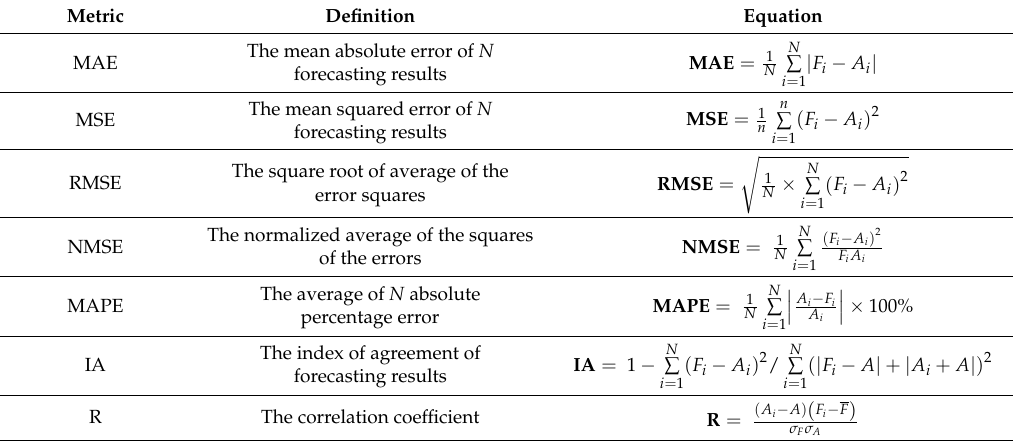
Table 3. The definitions and formulas of indexes involved in this